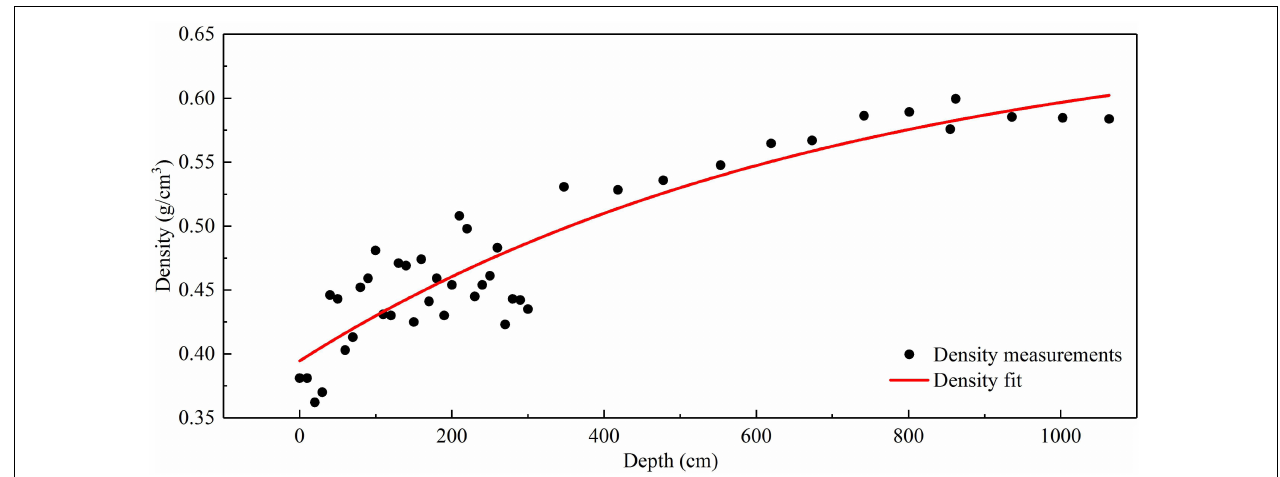
FIGURE 8 | Snow density profile of Taishan Station from a 10 m shallow snow